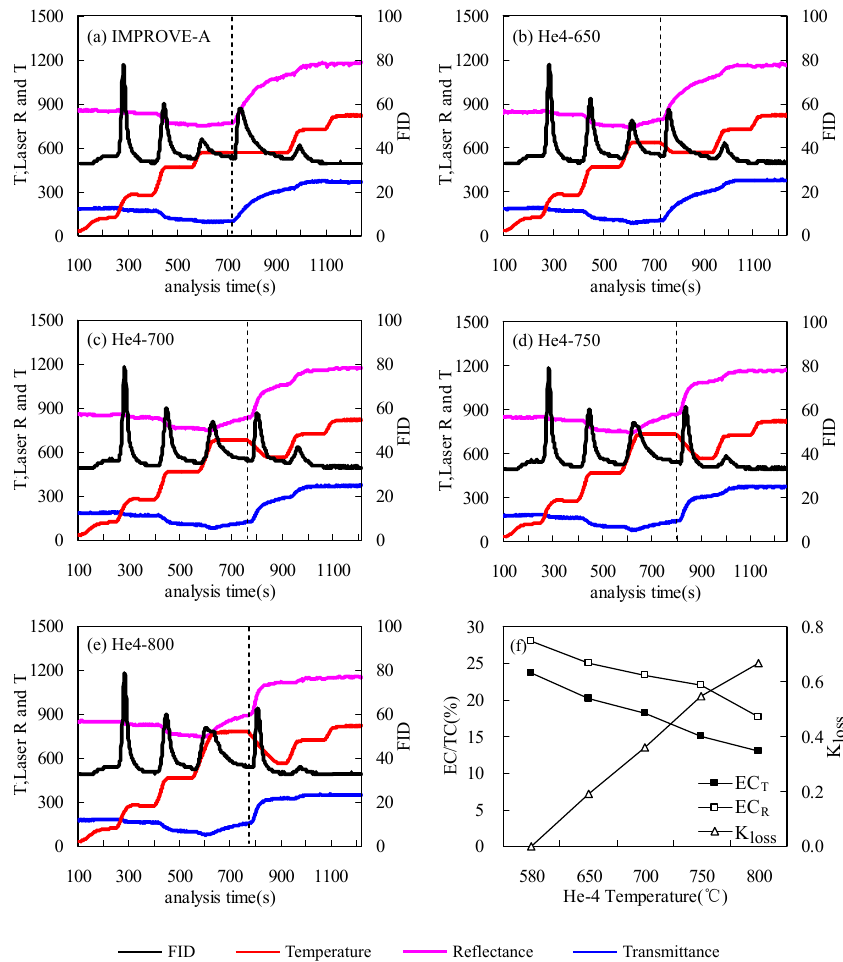
Fig. 4. Typical thermograms for a medium-loaded summer sample (TC=13µgC/m 3 ) obtained from the five protocols ( a – e ), with the dash line indicating the introduction of O 2 . Influence of peak inert mode temperature (He-4 temperature) on EC values defined by transmittance (EC T ) and reflectance (EC R ) correction, and on loss of light absorbing carbon ( K loss ) is shown in (f).